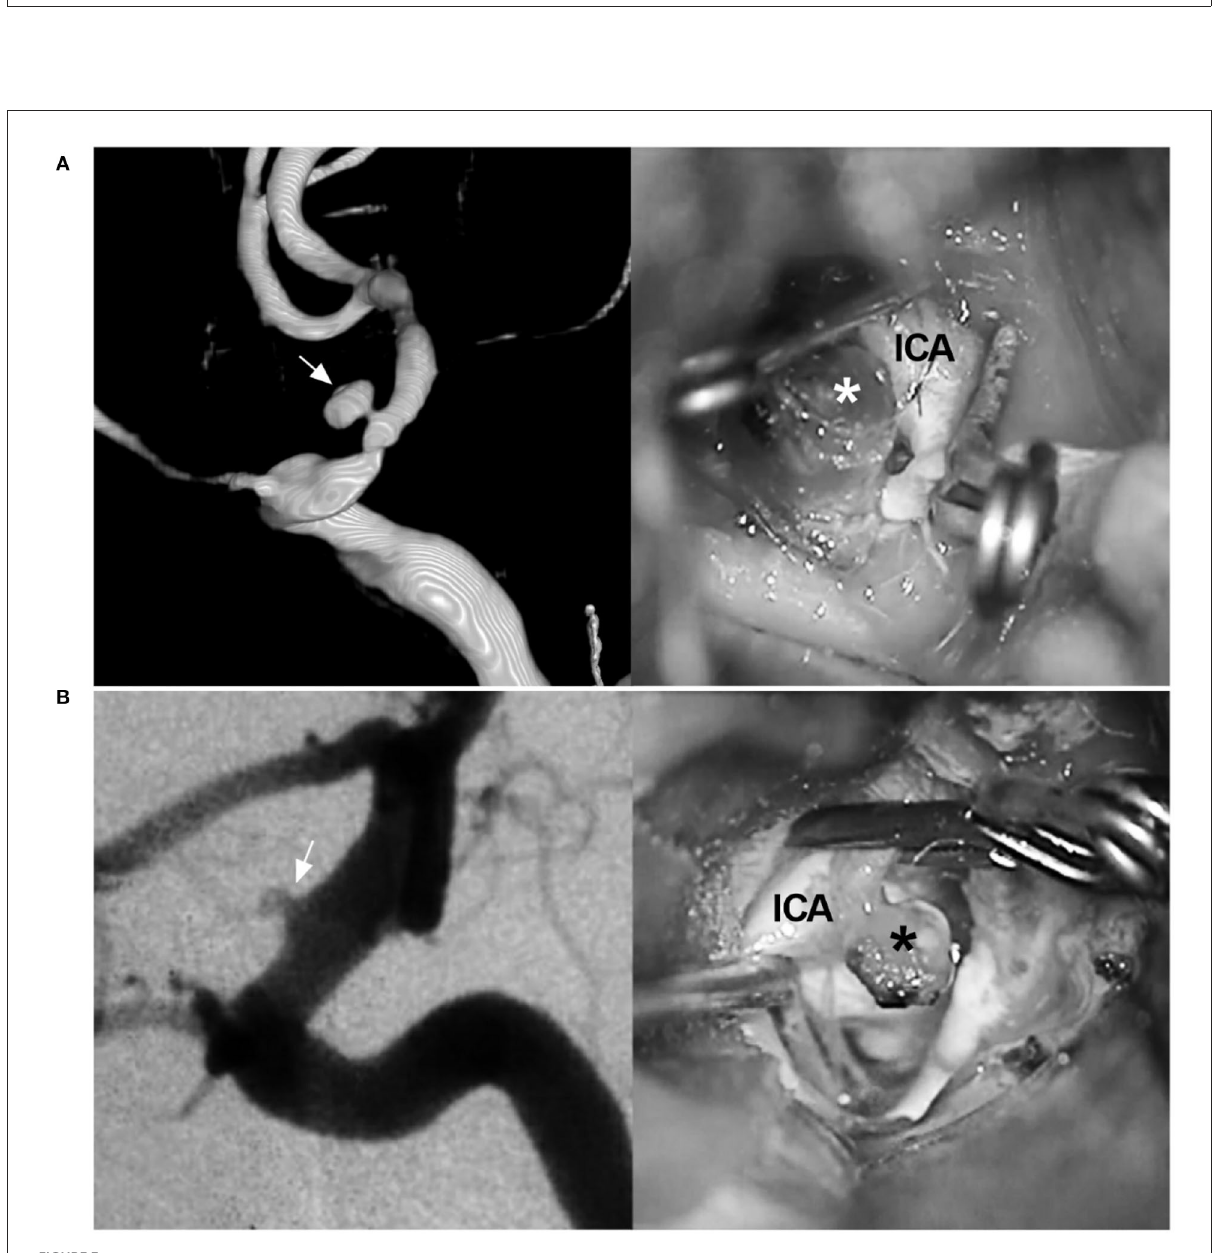
FIGURE3 BBA and its differential diagnosis. (A) Left: Three-dimensional DSA of the ICA shows a mushroom-shaped BBA (arrow) on the paraophthalmic segment; Right: intraoperative image shows the fragile BBA without a definite neck (asterisk). (B) Left: DSA of the ICA shows an aneurysm (arrow) exactly like the BBA on the paraophthalmic segment; Right: intraoperative image shows that the aneurysm is saccular with a definite and stable neck (asterisk). BBA, blood blister-like aneurysm; DSA, digital subtraction angiography; ICA, internal carotid